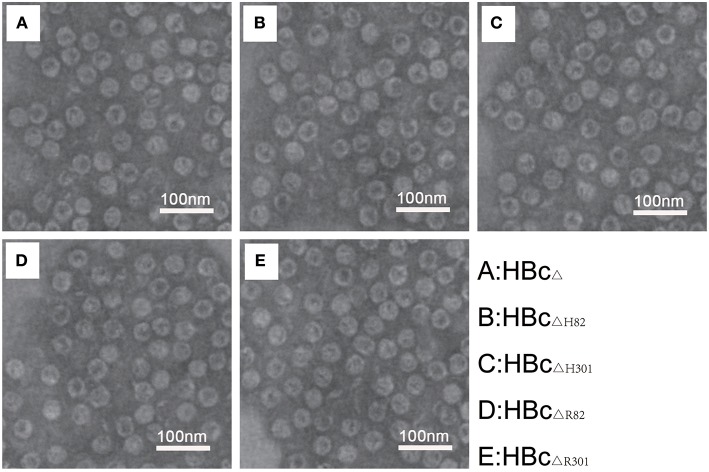
Electron microscopic characterization of VLPs. Transmission electron microphotographs of the chimeric HBc particles [HBcΔ
(A), HBcΔH82
(B), HBcΔH301
(C), HBcΔR82
(D), and HBcΔR301
(E)] showing regular morphology of the VLPs in each preparation. Images were generated using 1% phosphotungstic acid as a negative stain. Magnification 120, 000×. Scale bar, 100 nm.